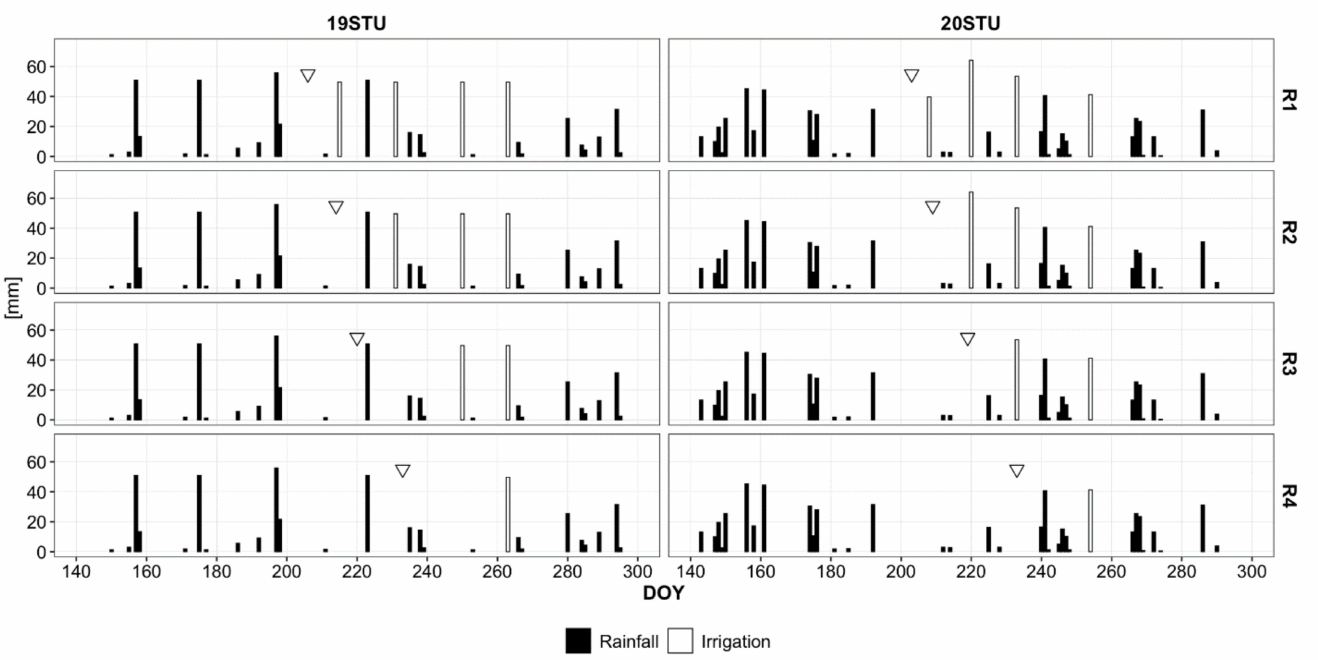
Figure 3. Daily distribution of rainfall and irrigation (mm) during the two growing seasons (2019 and 2020) in Stuttgart (STU). DOY: day of the year. The symbol indicate the time of canopy wilting